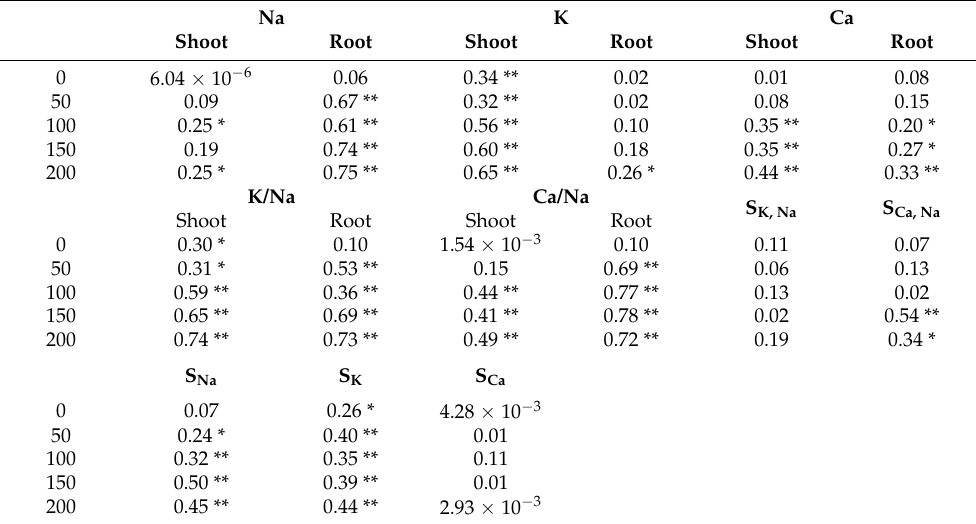
Table 2. Correlation coefficients between the shoot and root ion contents, absorption, and transport, and different salt-tolerance grades of B. napus under various NaCl concentrations. Na